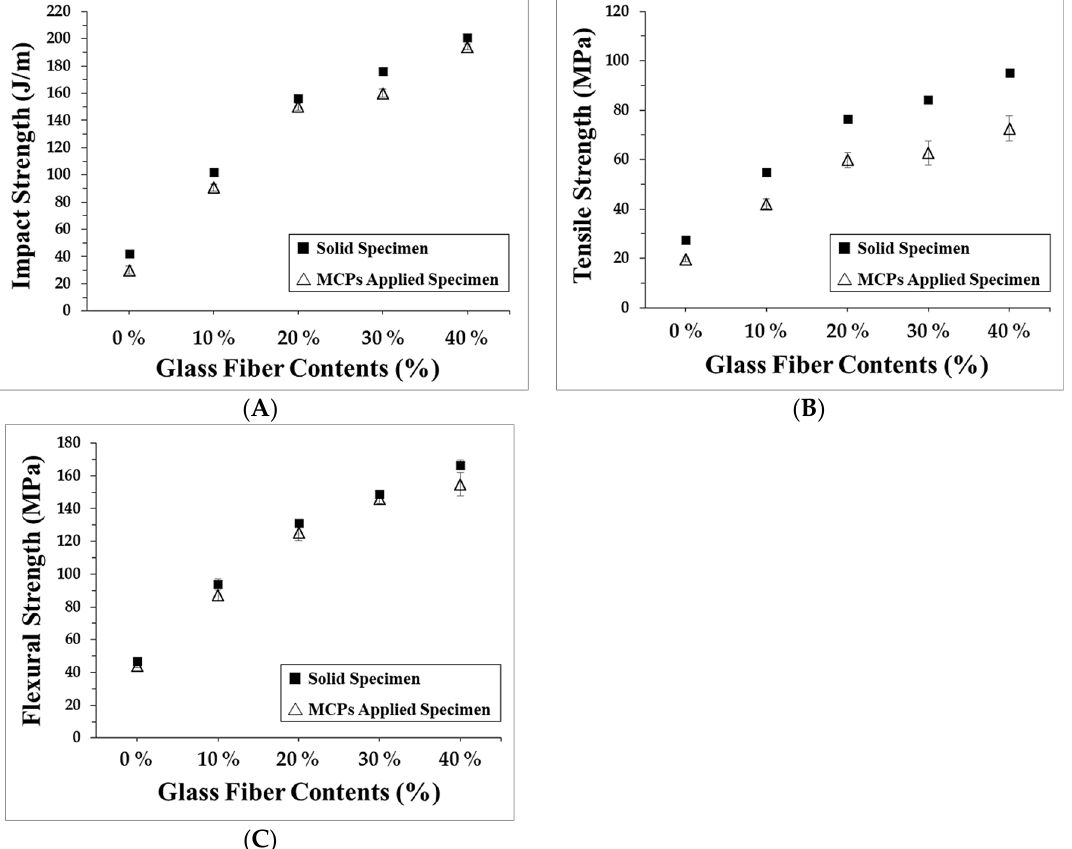
Figure 9. Mechanical properties: ( A ) impact strength, ( B ) tensile strength, and ( C ) flexural strength.